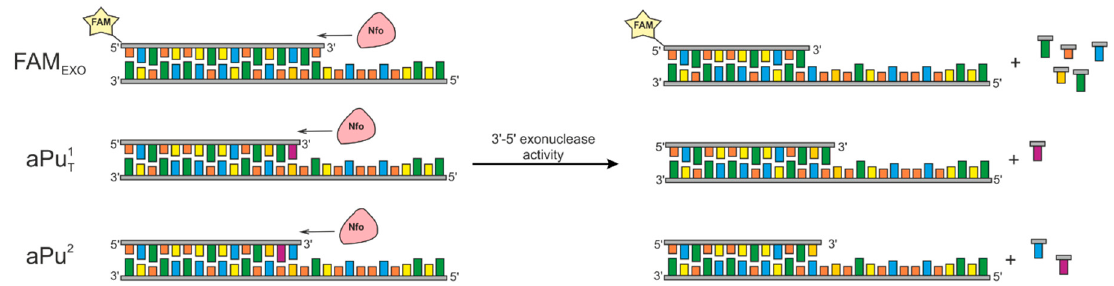
Figure 2. The model DNA substrates for studying the 3  ‐ 5  ‐ exonuclease activity of